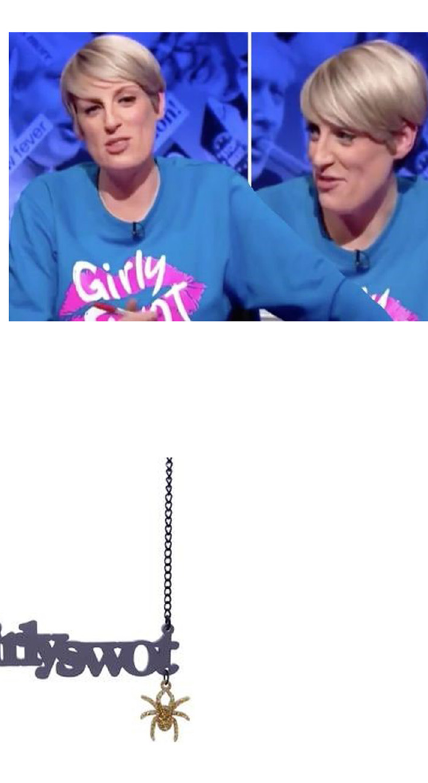
Figure 2: “ Girly swot ” reclaimed: